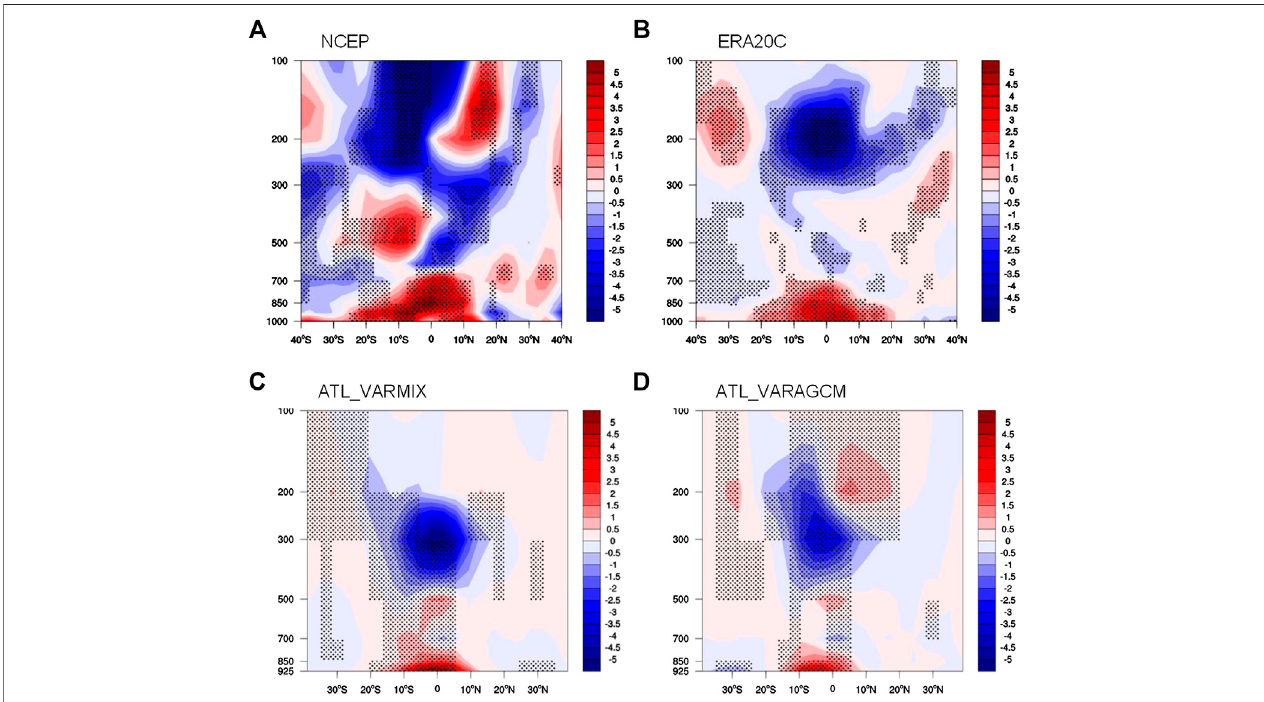
FIGURE7| Thezonalmeanmeridionalwind(10 − 2 m s − 1 )regressedonthenormalizedAMVindexderivedfromtheobservationaldatasets: (A) NCEPdatasetfrom 1948 to 2013, (B) ERA20C data set from 1900 to 2010, and experiments: (C) ATL_VARMIX, and (D) ATL_VARAGCM for the period 1900 – 2013. Dotted shading indicates the regression coef fi cients signi fi cant at the 95% con fi dence level.